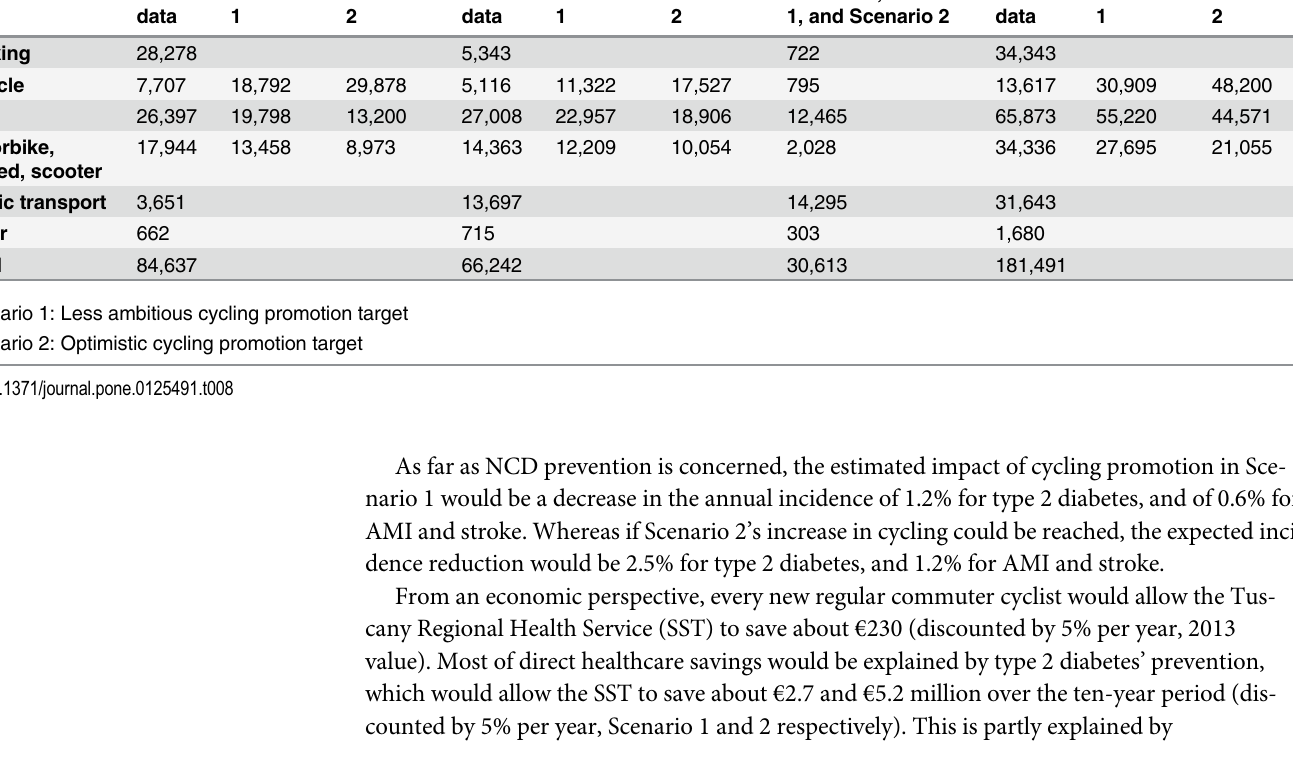
Table 9. NCD prevention and healthcare direct costs savings (5% discount rate per year) based on Florence cycling promotion scenarios over a ten-year period (2013 – 2022). Incident cases prevented over a 10-year period (2013 – 2022)